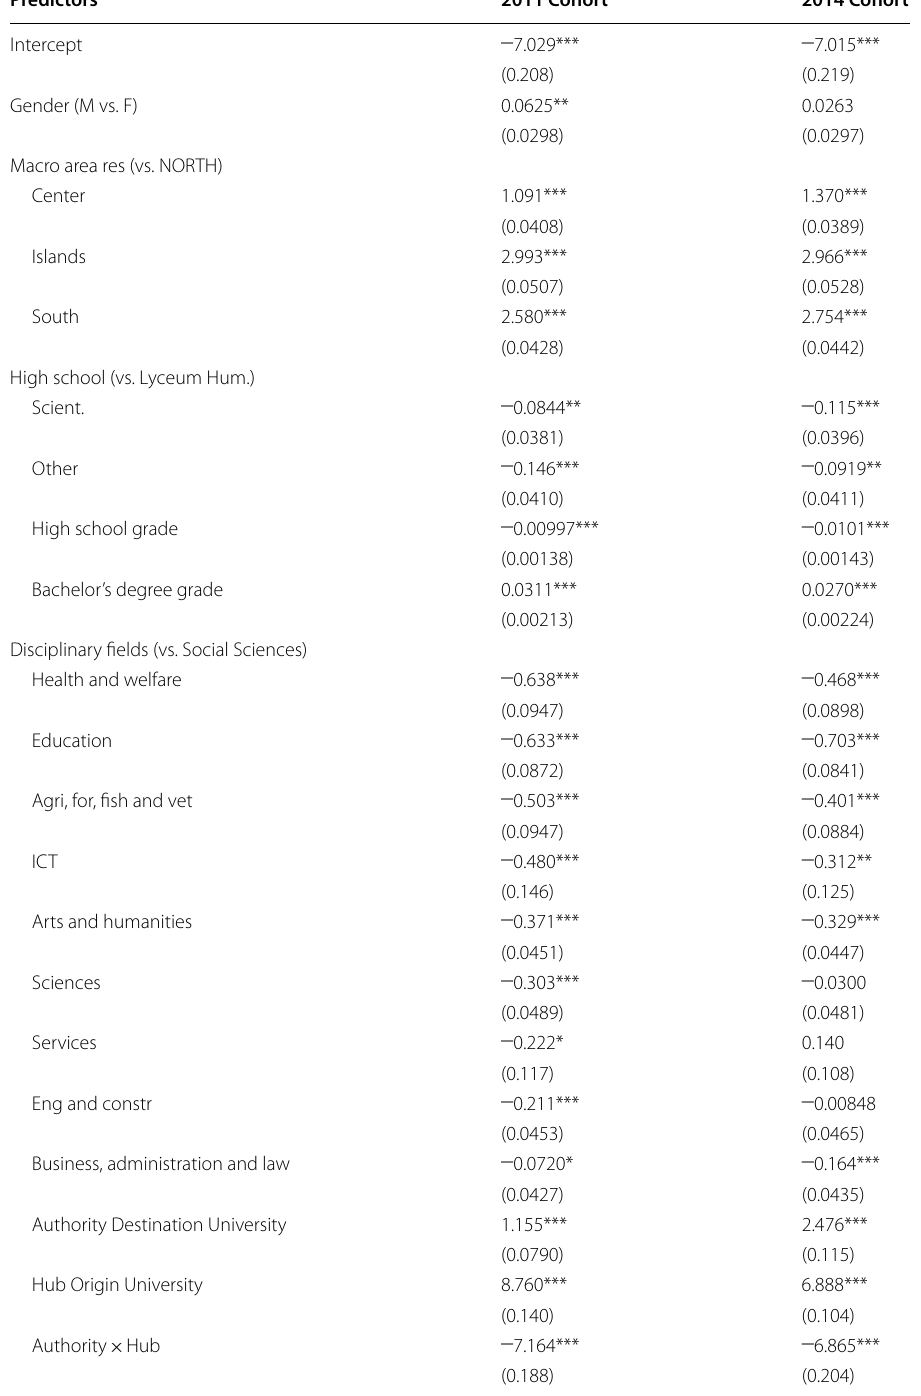
Table 4 Logistic parameters estimates (SDs in brachets) Predictors